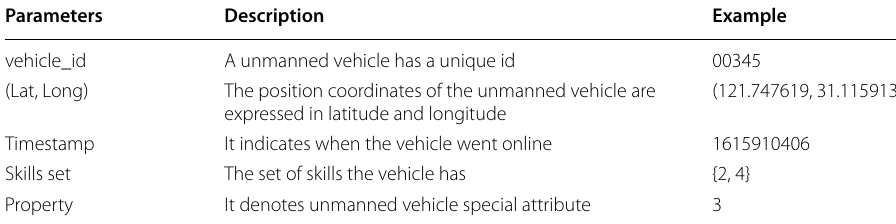
Table 6 Data of vehicle parameter